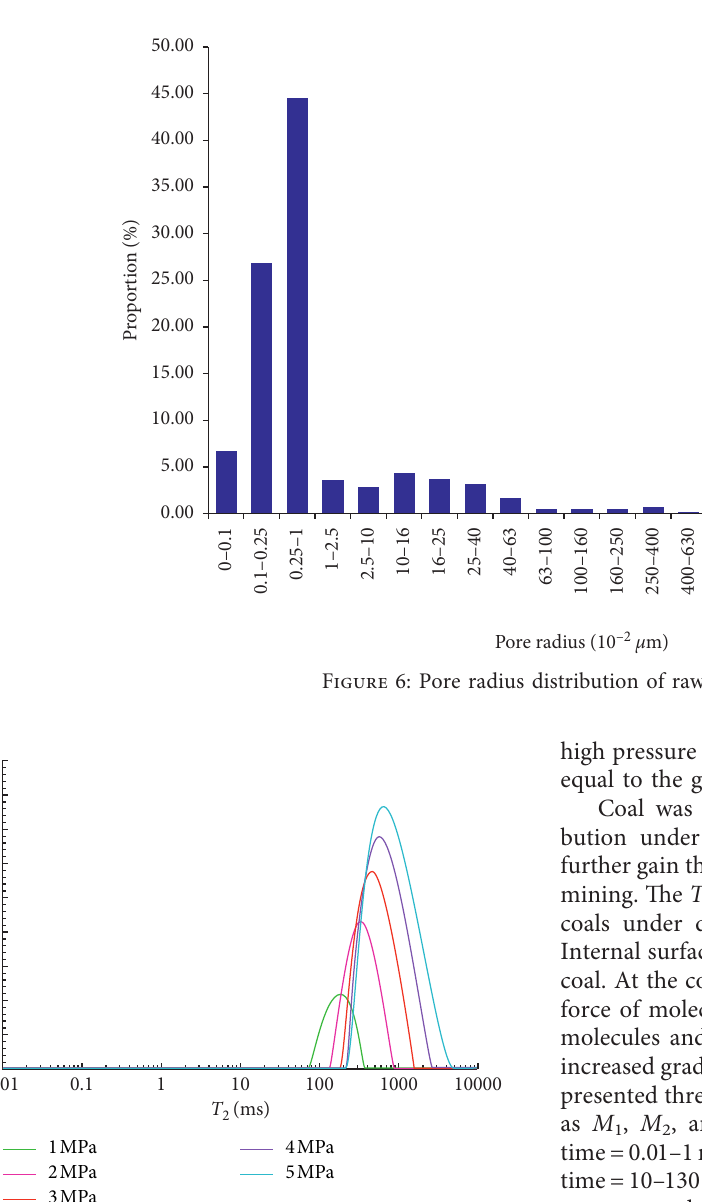
Figure 7: Signal amplitude of gas under different pressures.